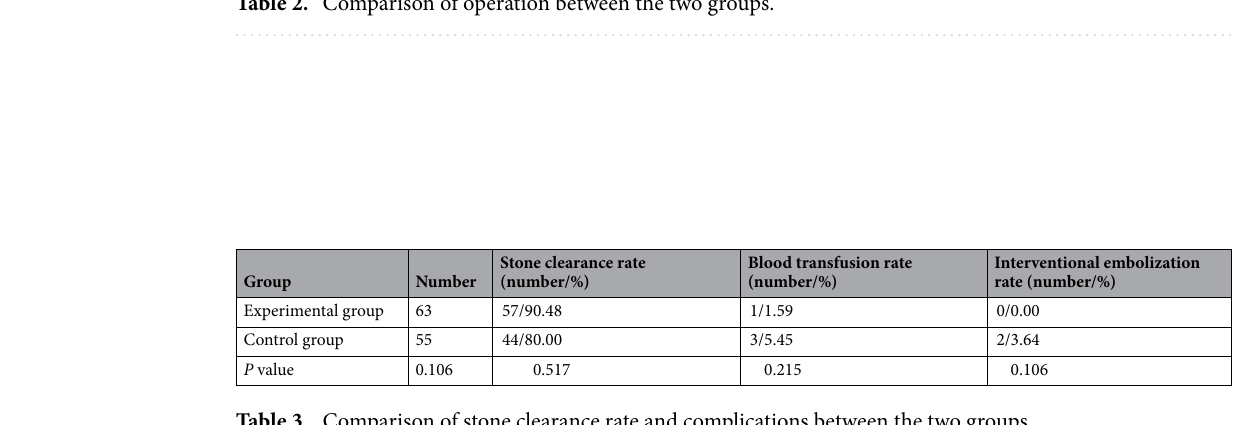
Table 3. Comparison of stone clearance rate and complications between the two